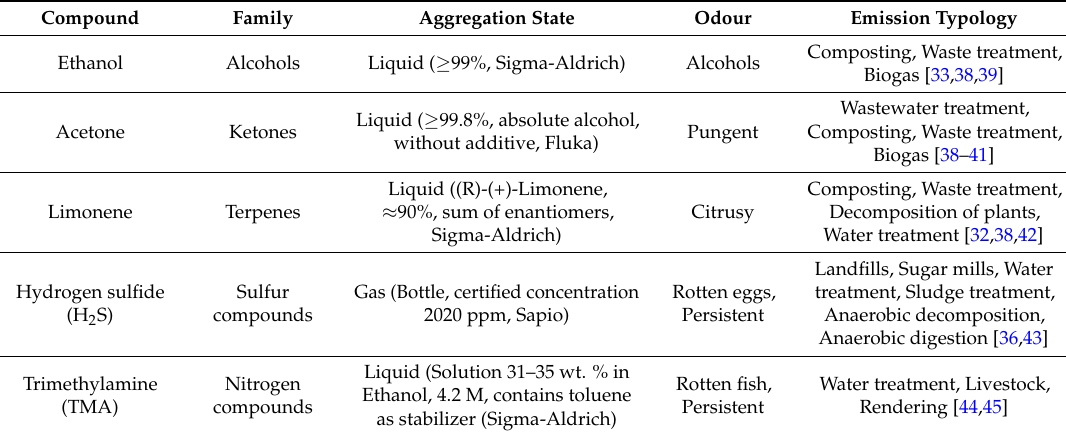
Table 1. Selected target compounds for electronic nose